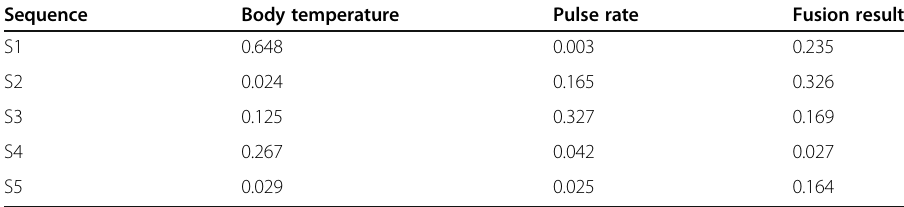
Table 2 Fusion results of body temperature and pulse rate Sequence Body temperature Pulse